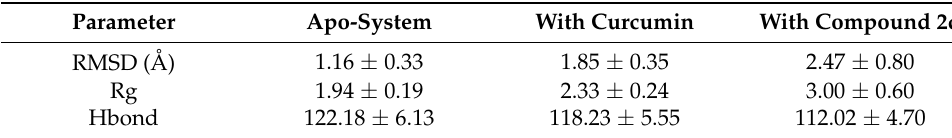
Figure 5. ( A ) RMSD of the C α of the oligomer in the absence (Apo) and presence of curcumin (Cur) and compound 2d as ligands. ( B ) Rg of the C α of the oligomer in the absence and presence of ligand. ( C ) Number of H bonds among the monomers of the oligomer in the absence and presence of ligand. ( D ) First snapshot (t = 0 ns) of the Apo-system. In the system complexed with ligand, the ligand will be placed in the central hole. ( E ) Last snapshot (t = 40 ns) of the Apo system. ( F ) Last snapshot (40 ns) of the 2d -complexed system. The ligand is coloured in green. Table 4. Summary of the structural parameters determined for each system.